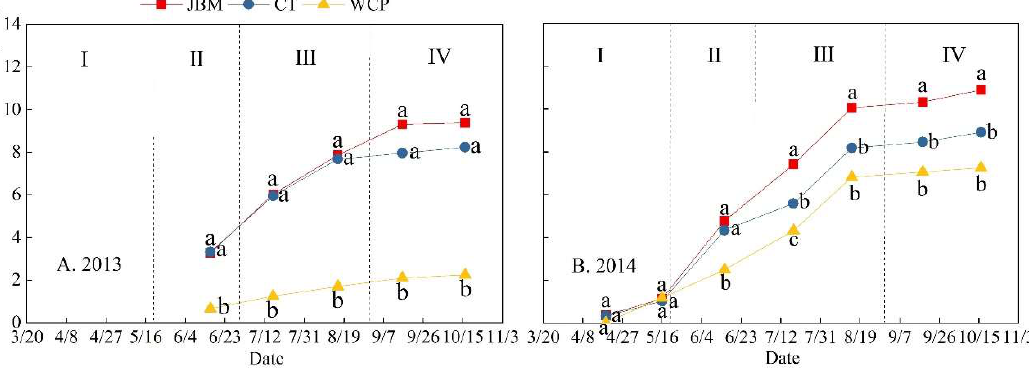
Figure 4. Jujube stem diameter changes over time under different mulching measures in the ( A ) 2013 and ( B ) 2014 jujube growth periods. Different lowercase letters on the same day of the same experimental year indicate significant differences in the cumulative stem diameter growth among treatments, as determined by Tukey’s test ( p < 0.05). Due to the fact that the 2013 experiment began a bit later than usual, the increase in jujube stem diameter during the budding and leaf-expanding stage could not be